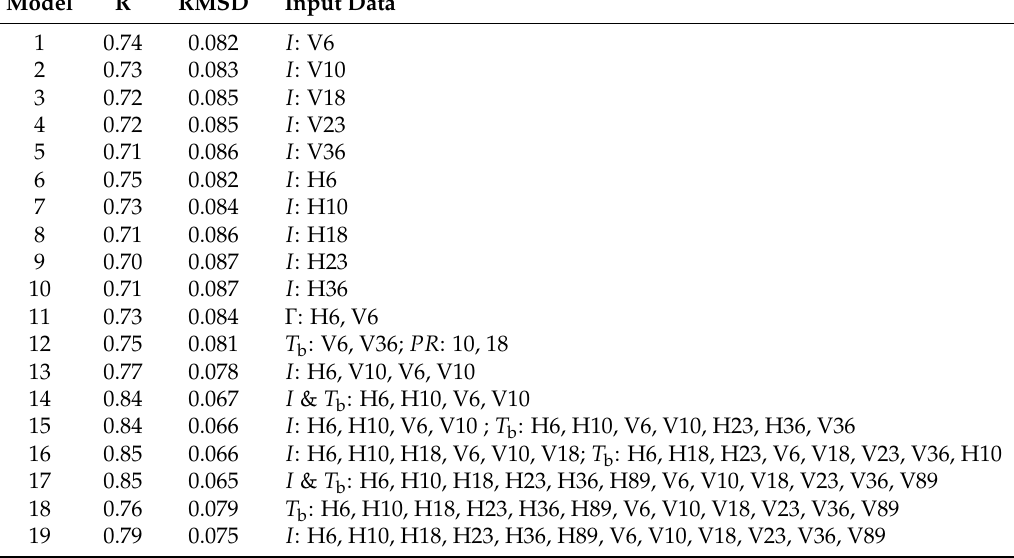
Table 3. Evaluations of the performances of the AMSR-E NN soil moisture (SM) with respect to the SMOS L3 SM reference data. Column 1 shows the model label. Columns 2 and 3 show the Pearson correlation and the root mean square difference of the NN SM with respect to SMOS SM. Column 4 shows the elements of the input vector: T b ’s, SM linear expectations I or reflectivity Γ = ( 1 − T b for different polarizations (H or V) and frequency bands (number in GHz) or polarization ratios H − T V PR = T b b for different frequency bands (number in GHz). The correlation uncertainty due to the T H b + T V b training is 0.01 (Section